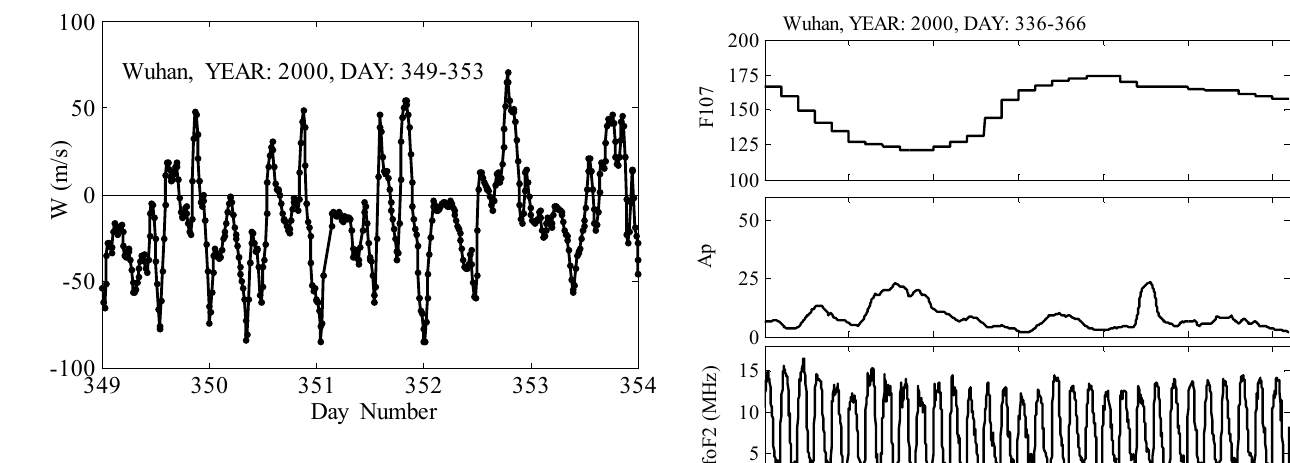
Fig. 5. Temporal variation of the vertical component of equivalent winds derived from the ionosonde measurements shown in Fig. 4. Positive upward.